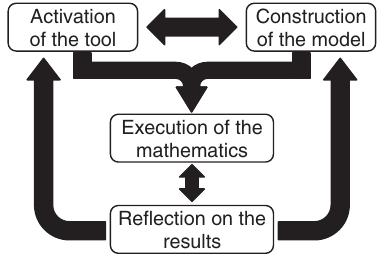
FIG. 1. A visual representation of the ACER